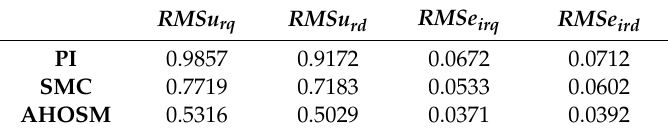
Table 2. RMS for tracking errors and control